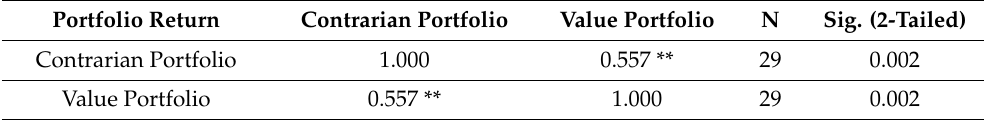
Table 5. Pearson correlation between portfolio returns of contrarian and value for year t +